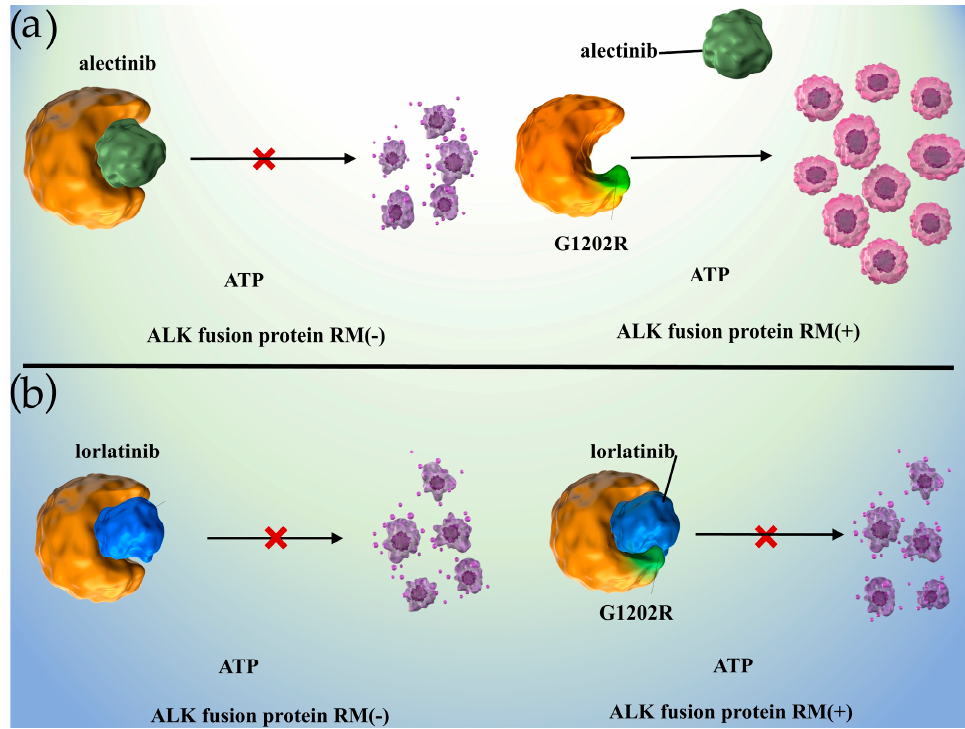
Figure 2. Different pharmacological activities of ( a ) alectinib and ( b ) lorlatinib toward ALK fusion proteins with resistance mutations. ( a ) Resistance mutations (e.g., G1202R) prevent alectinib from combining with the ATP-binding domain of the ALK fusion protein. ( b ) Lorlatinib successfully associated with the ALK fusion protein’s ATP-binding pocket with resistance mutations, and downstream signals associated with tumor progression are downregulated; ATP, adenosine triphosphate; RM, resistance mutation; ALK, anaplastic lymphoma kinase.